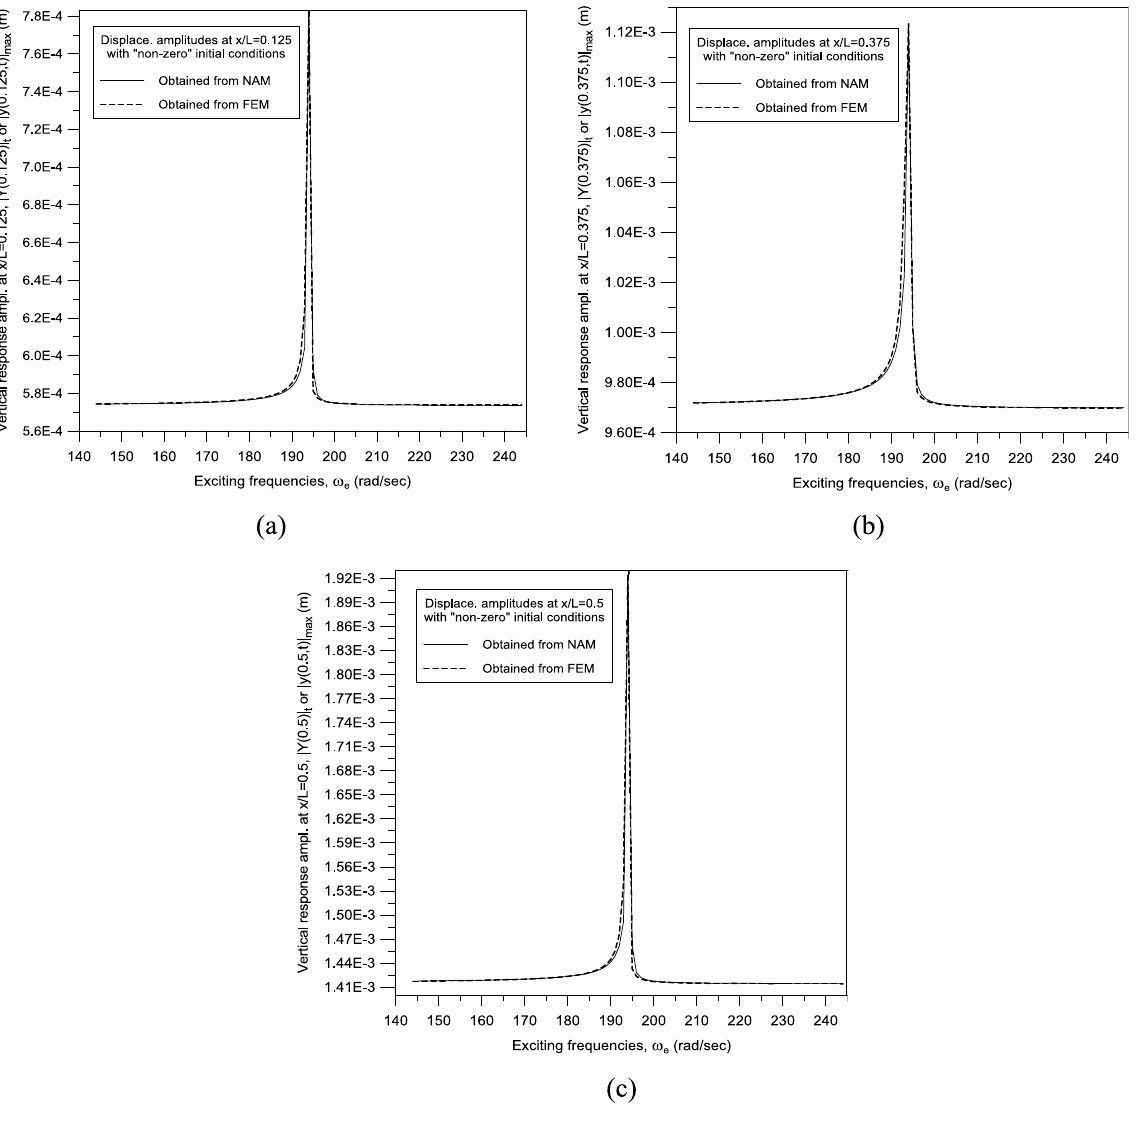
Fig. 10. The frequency-response curves for the three points p 1 , p 2 and p 3 on the beam (with “non-zero” initial conditions) shown in Fig. 6(a), located at: (a) ξ = x / L = 0.125, (b) ξ = x / L = 0.375 and (c) ξ = x / L = 0.5, respectively. ( − ¯ A sin βx + ¯ B cos βx + ¯ C sinh βx + ¯ D cosh βx i i i i i i i i